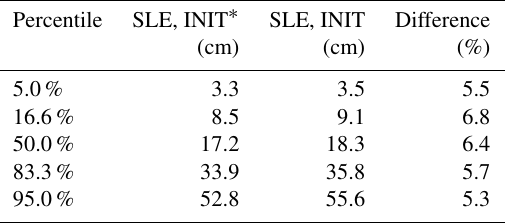
Table 2. Percentiles of the probability distribution of the sea level contribution from Antarctica under the RCP8.5 climate scenario from 2015 to 2100, estimated following the LARMIP-2